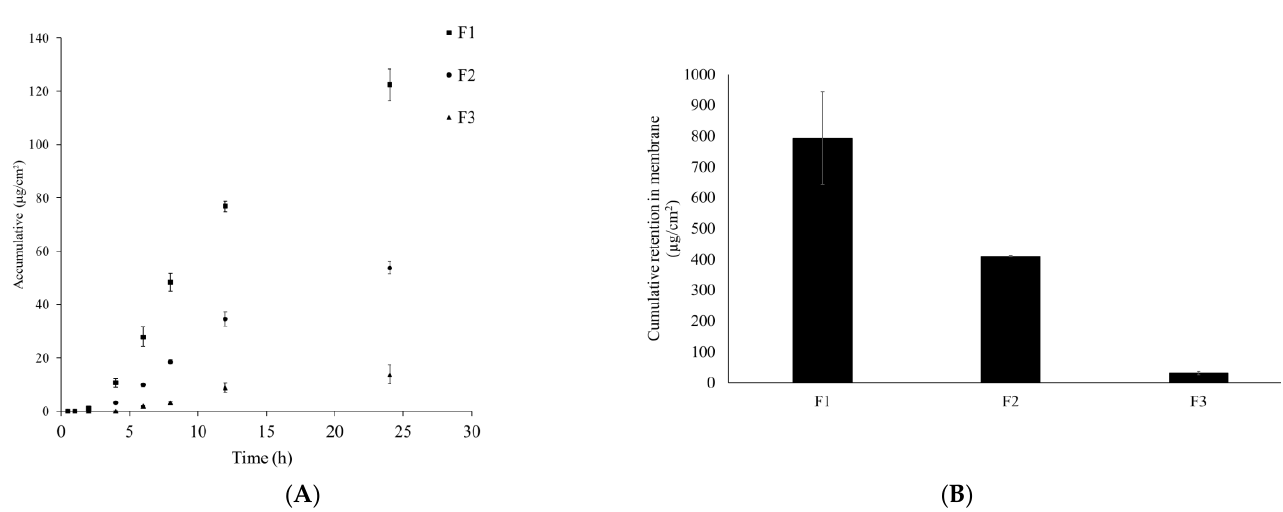
Figure 8. Comparison of in vitro permeation results of THC between nanoemulsion F1, micellar solution F2, and THC suspension ( A ). Comparison of the cumulative retention of THC in the membrane after 24 h ( B ).